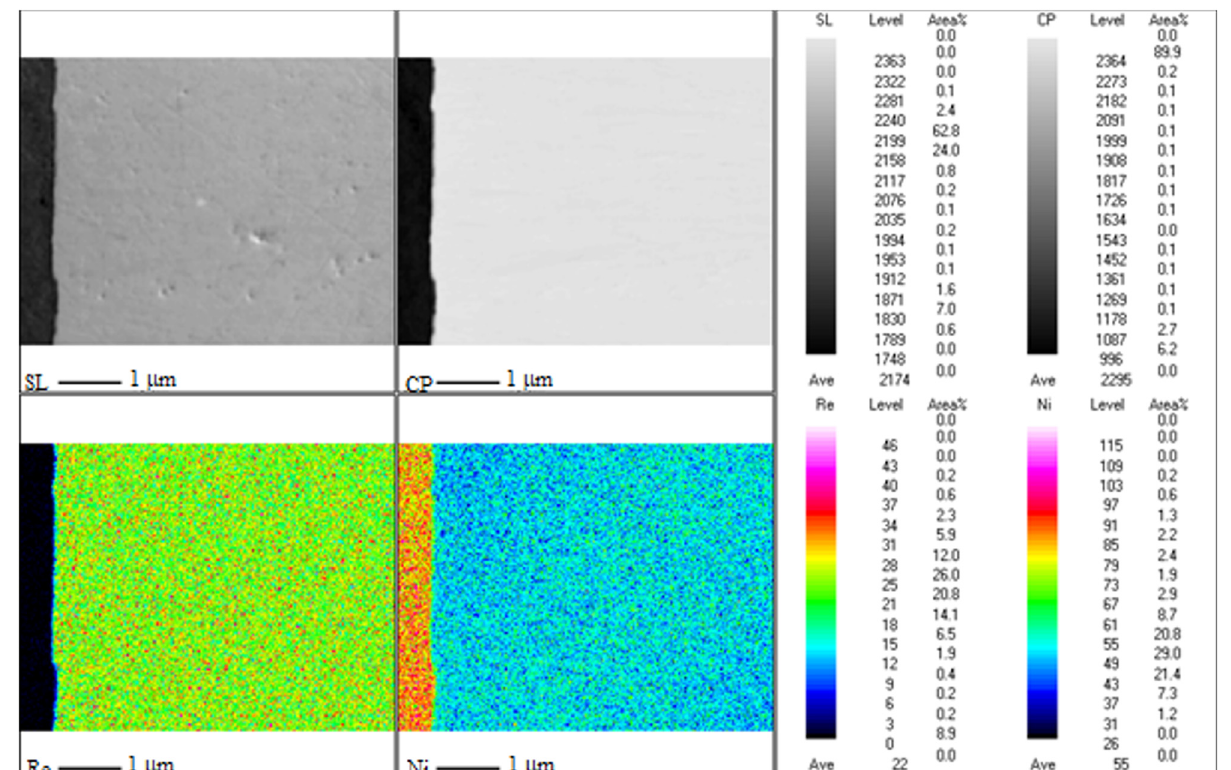
Figure 3: Cross - section of the Ni – 37Re coating ( j = 25 mA · cm − 2 , 5 g · L − 1 of ammonium rhenate ( VII ) in the bath )